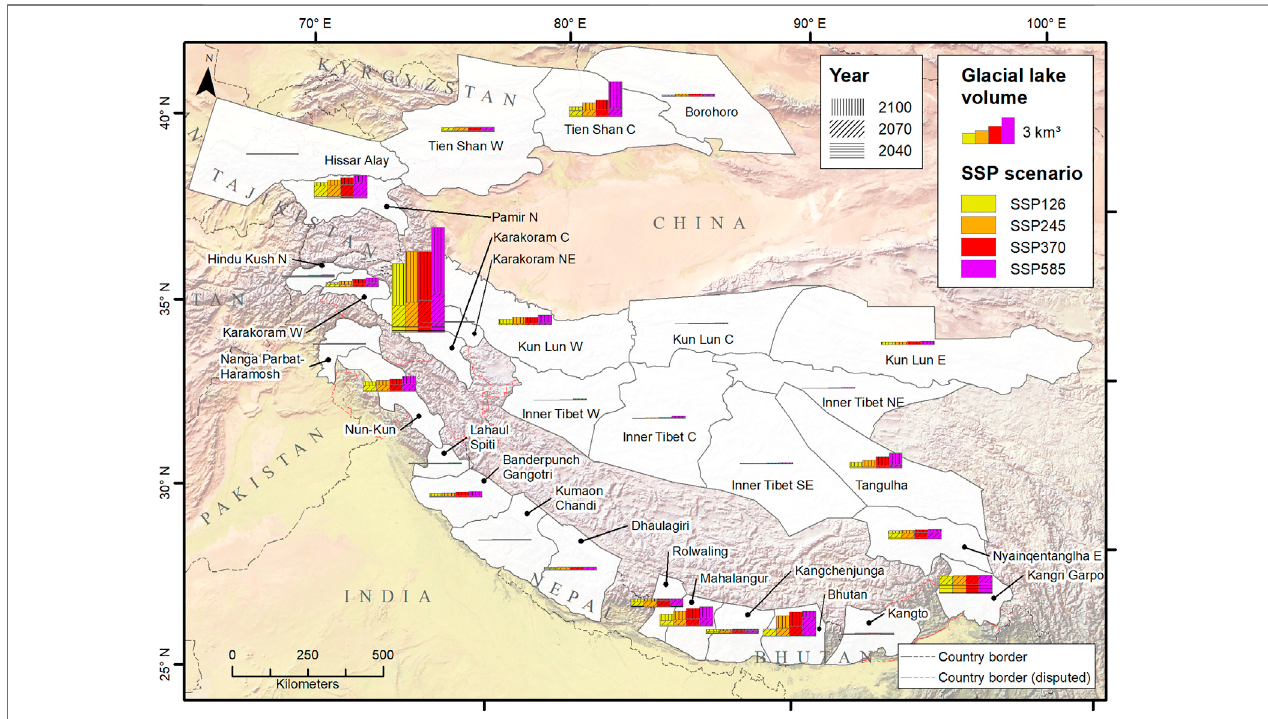
FIGURE3| GlaciallakevolumeincreaseinHMAunderfourSSPscenariosuptothreepointsintimeduringthe21stcentury.SSPscenariosarecolor-coded,years are indicated by different dashes. Regions with < 0.1 km 3 of additional lake volume in 2100 (SSP585) are excluded for reasons of clarity.